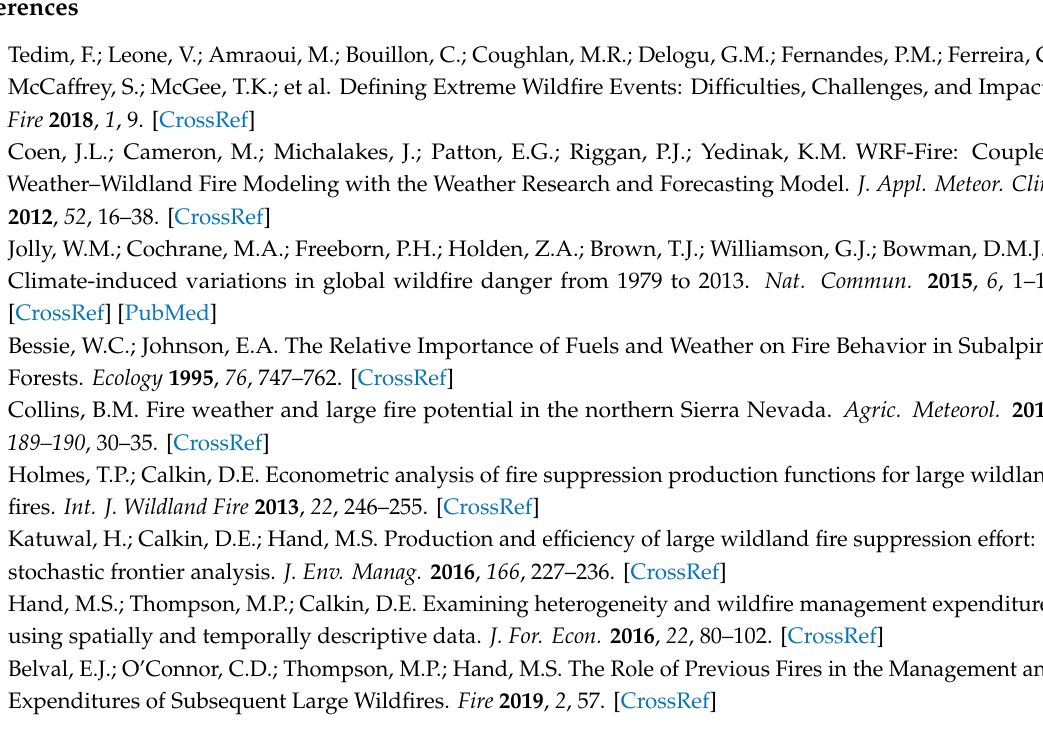
Table S1: Summary Statistics used in each Model, Table S2: Complete Results of Quasipoisson Regression of Fire Growth, Table S3: Complete Results of Ordered Logit Regression of Growth Potential, Table S4: Complete Results of Fixed E ff ects Regression of Total Resource Orders, Table S5: (a) Complete Results of Fixed E ff ects Regression of Select Resource Orders, (b) Complete Results of Fixed E ff ects Regression of Select Resource